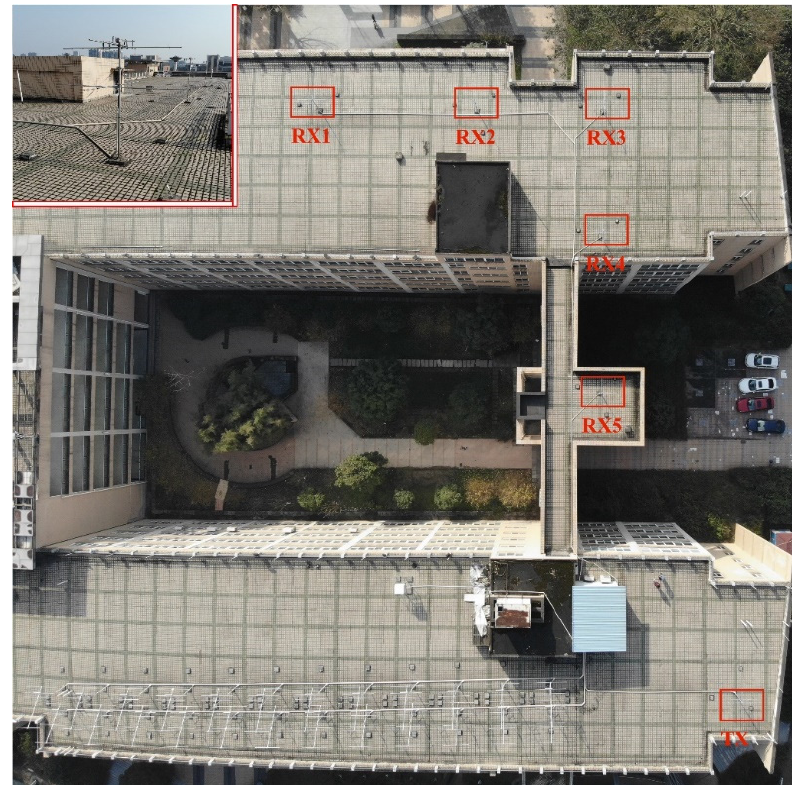
Figure 3. Photography of Leshan VHF radar antenna array. Table 1. Leshan VHF radar operational parameter.